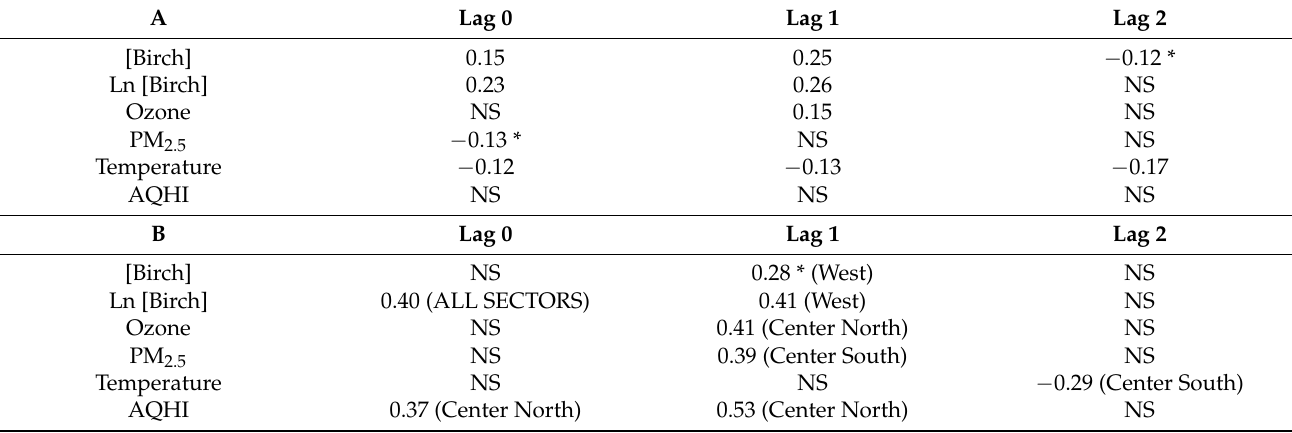
Figure 4. Relation between birch SPI (seasonal pollen index) and daily asthma hospitalization count for the spring period 2006–2012. Table 2. Correlation between asthma hospitalization and selected environmental factors in Montreal during the pollen season 2006–2008: ( A ) all sectors of Montreal and all weather types; ( B ) discriminated for geographical sectors and weather types (weather types 7,9 and 12 only). W: West Montreal; CN: Center North; CS: Center South. Note. [Birch] refers to birch airborne